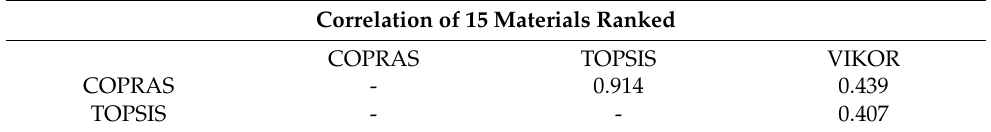
Table 20. Spearman’s correlation.